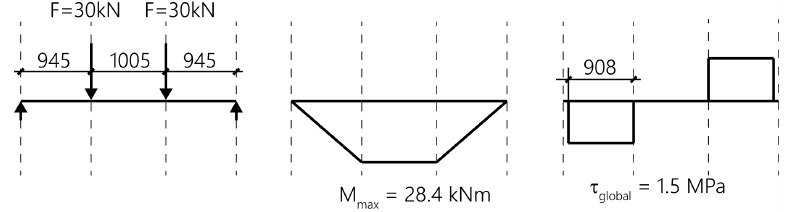
Figure 19. Static system, flexural moment and global shear stress between the steel plate and the concrete surface of the long-term beam test shown in Figure 13.